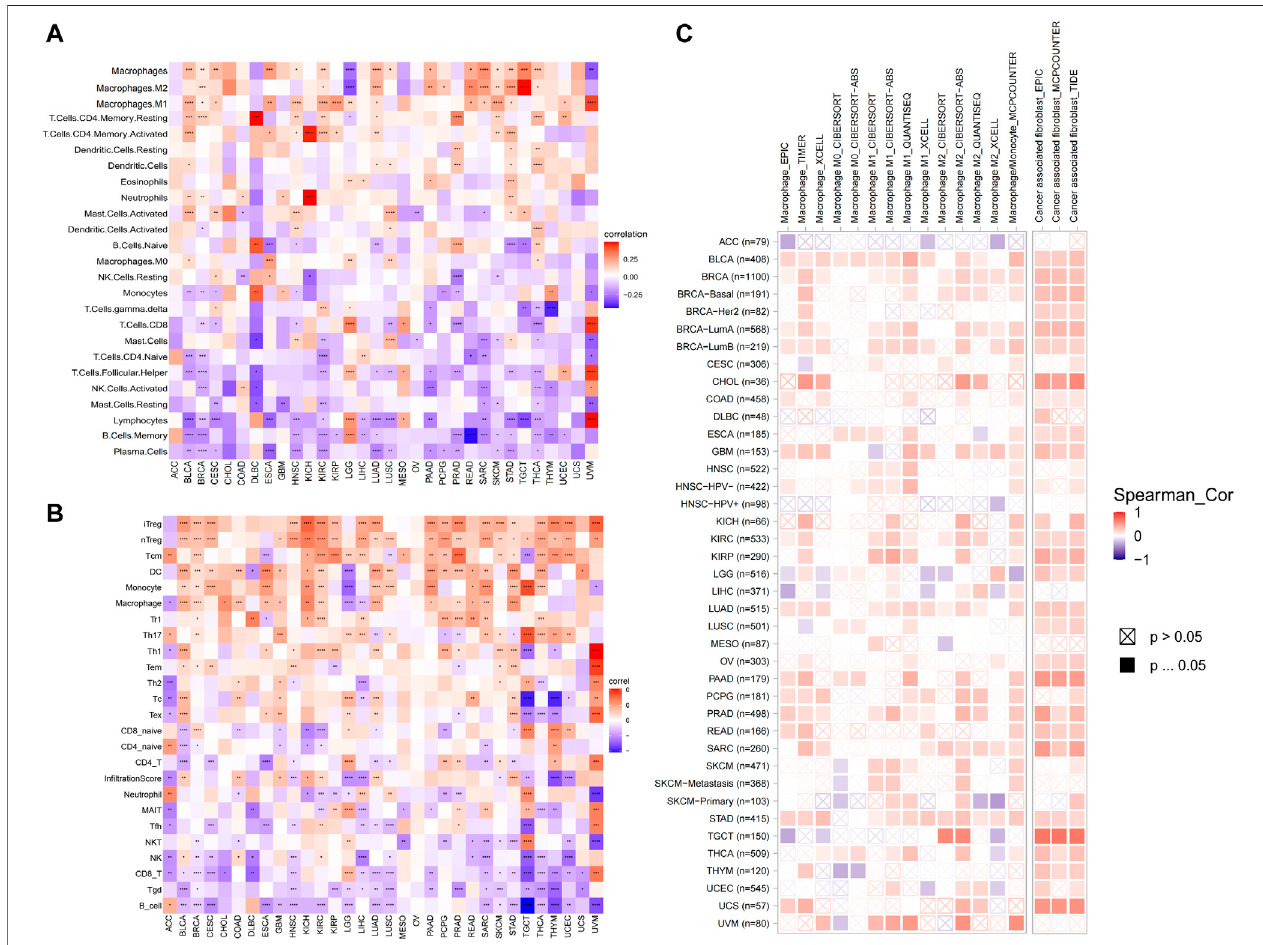
FIGURE 9 | The relationship between AP3S1 and the immune cell in fi ltration. (A) Correlation between AP3S1 and different immune cells from previous study. (B) Correlation between AP3S1 expression and different immune cells from ImmuCellAI database. (C) Correlation between AP3S1 expression and TAMs/CAFs from TIMER2 database. Red represents positive correlation, blue represents negative correlation, and the darker the color, the stronger the correlation. * p < 0.05, ** p < 0.01, *** p < 0.001.